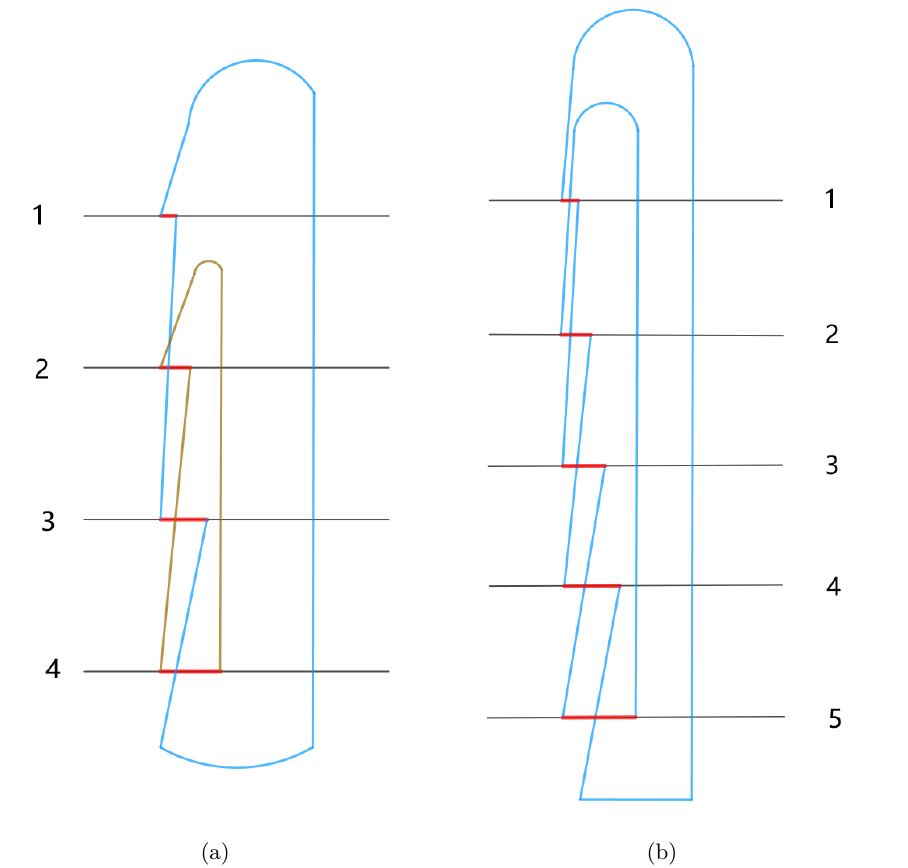
Figure 5 . Contour configurations representing the OPE of two twist operators σ l σ l . The red lines show the shifts in y direction, which is fixed by σ operator. (a): A typical example for l even l ( l = 4 ) showing how the sheets decouples into two independent sets, each of l/ 2 replica sheets, and how the boundary condition in y direction (3.56) are obeyed; (b): A typical example for l odd ( l = 5 ) showing the net effect is not just a reshuffling of the sheet numeration due to the non-trivial boundary condition in y direction